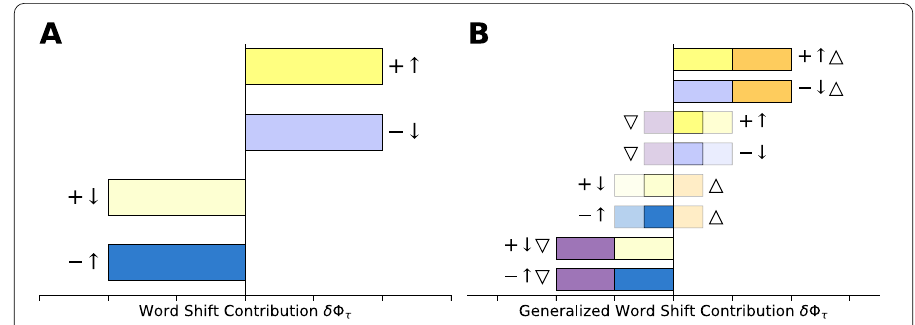
Figure 1 Types of word contributions in word shift graphs. ( A ) Word contributions in basic word shift graphs, which are determined by the interaction between the signs of the difference between the word score and the reference score (+/–) and the difference in relative frequencies ( ↑ / ↓ ) (see Sect. 3.1). For example, in sentiment analysis, a relatively positive word appearing more is indicated by a deep yellow bar to the right (+ ↑ ), while a relatively negative word appearing more is indicated by a deep blue bar to the left (– ↑